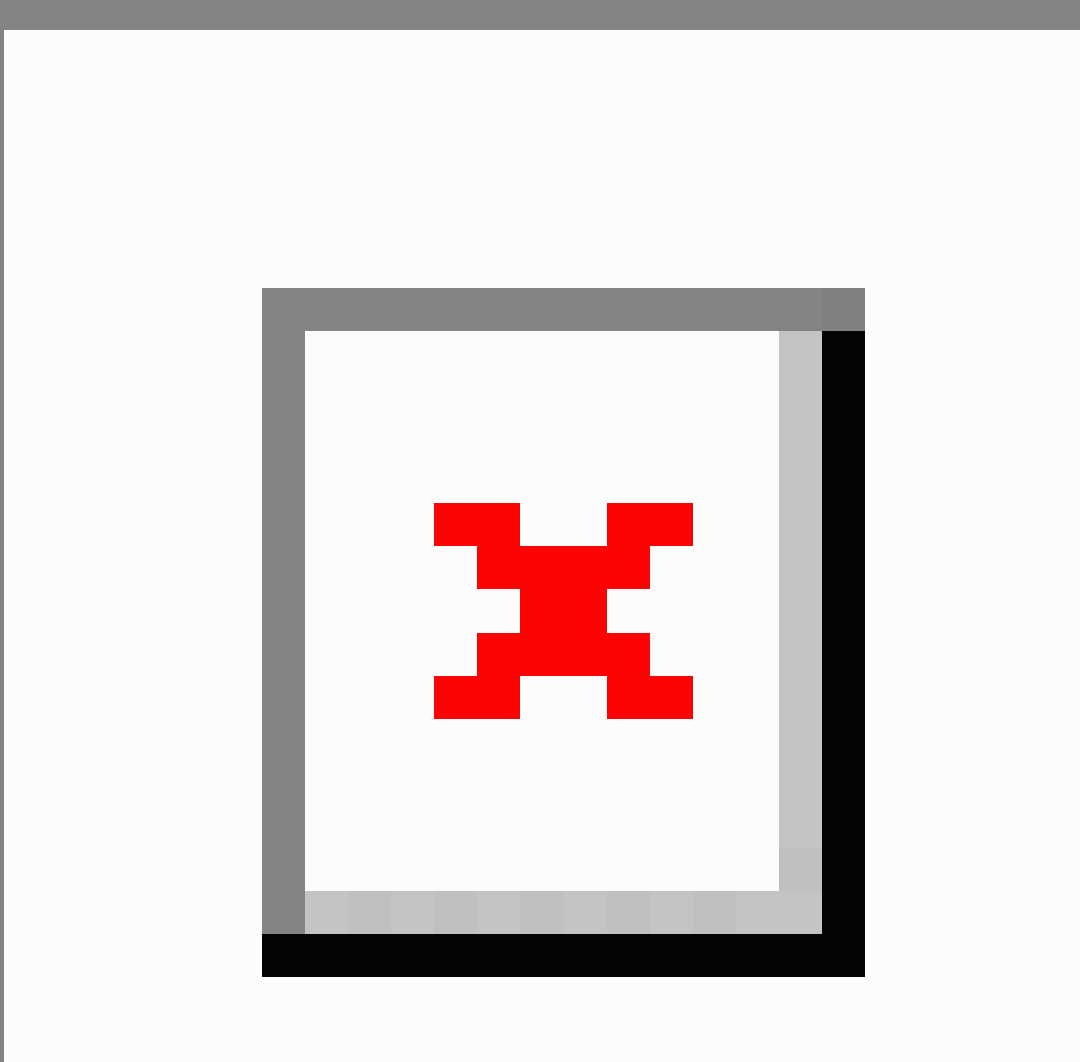
Figure 3. Direct effects of language features in a thread-starting post on the perception that the poster was seeking emotional and informational support and on the receipt of emotional and informational support. Values represent standardized regression coefficients. ε 1, ε 2, ε 3, and ε 4 indicate error terms. * P <.05; ** P <.01; *** P